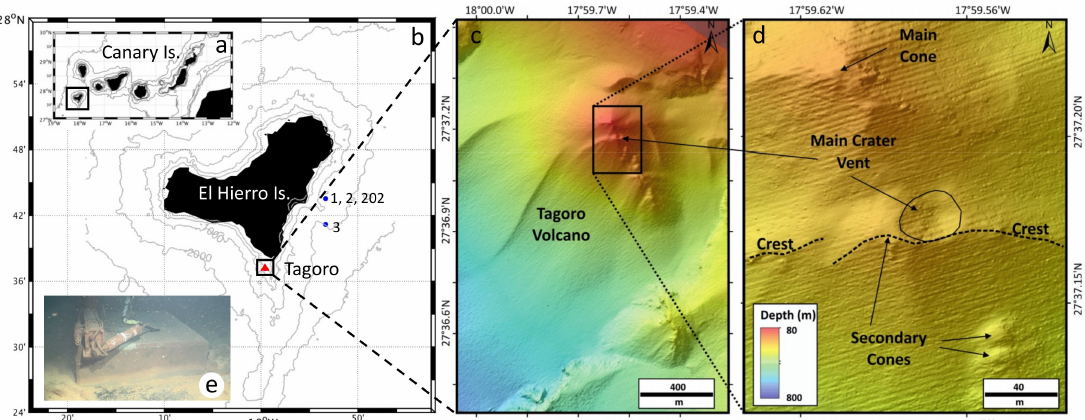
Figure 1. Location map. ( a ) Location of the island of El Hierro in the Canary Archipelago. ( b ) Locations of the Tagoro submarine volcano and the CTD ref. stations. ( c ) High resolution bathymetry of Tagoro submarine volcano. ( d ) High resolution bathymetry zoon at the area of the main crater vent. ( e ) Image from the ROV of the mooring deployed at the interior of the main crater vent before its recovery